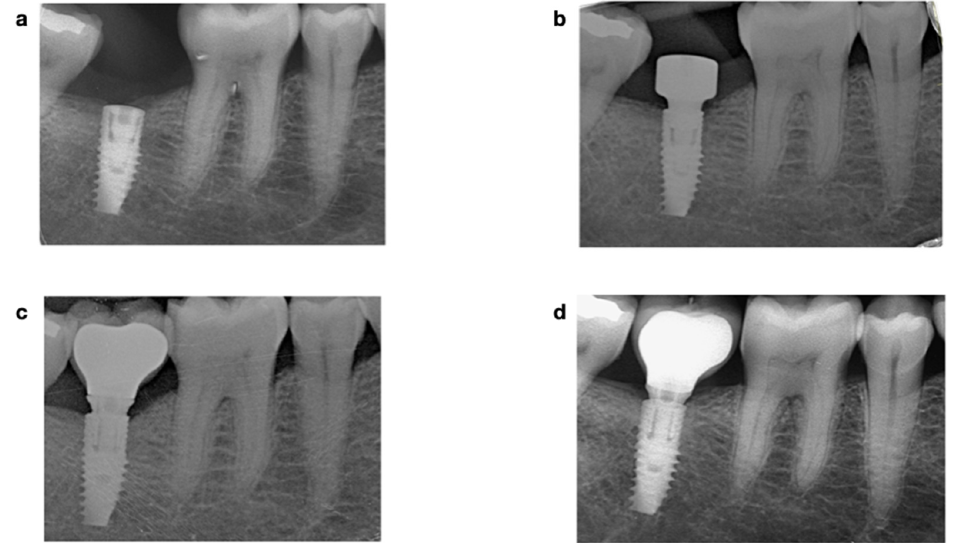
Figure 1. Periapical radiograph-parallel technique for MBL analysis at the 1-year follow-up. ( a ) 2- stage implant placement; ( b ) 2-stage surgery 4 months after implant placement; ( c ) CAD-CAM metallo-ceramic crown cemented to a 0.5 mm anti-rotatory Ti-base abutment at the 6-month follow- up; and ( d ) at the 1-year follow-up.